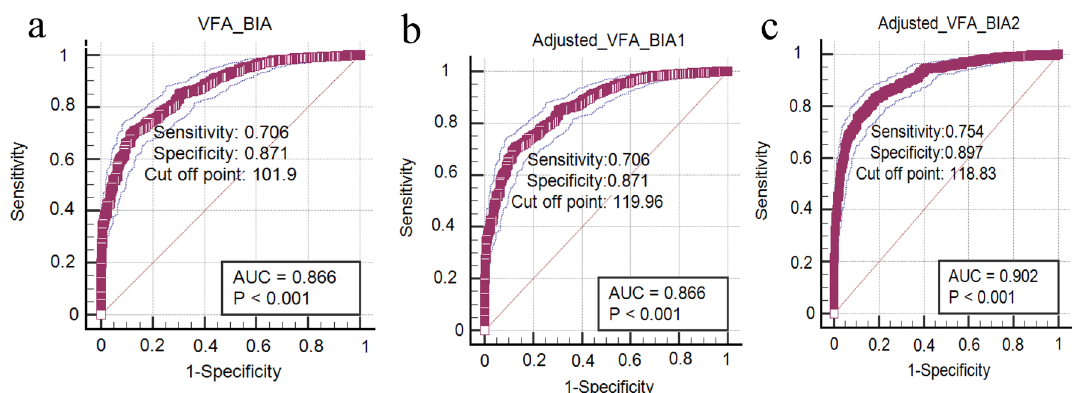
Figure 3. ROC of visceral obesity predicted by BIA in female. ( a ) The cut off point is 101.90 cm 2 in unadjusted model. ( b )The cut off point is 119.96 cm 2 in model 1, which is the univariate regression analysis of predicted VFA-QCT by VFA-BIA. ( c )The cut off point is 118.83 cm 2 in model 2, which is the multivariate regression analysis of predicted VFA-QCT with VFA-BIA, age, BMI, and